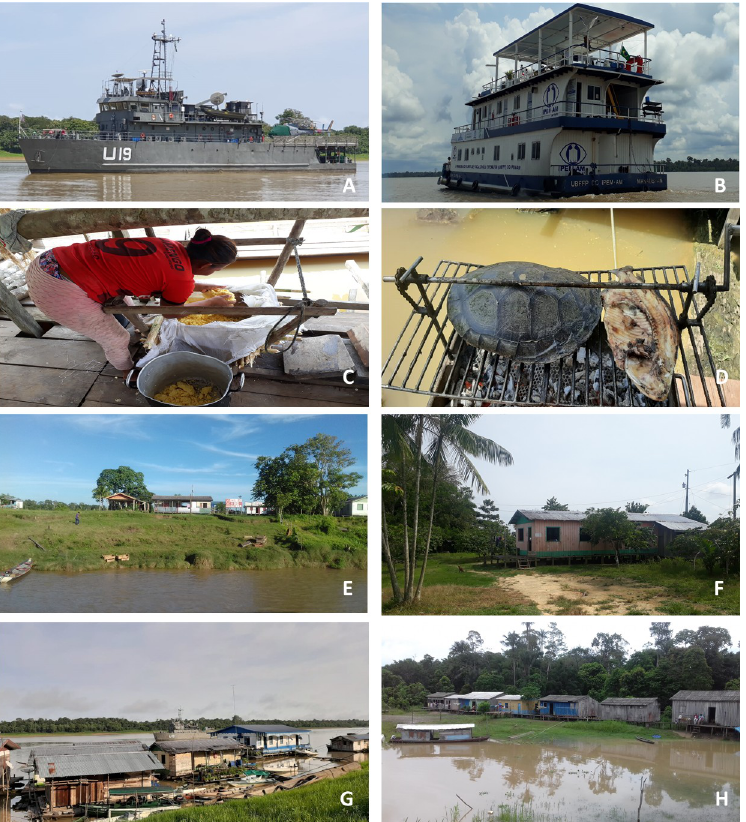
Fig 2. Means of transport used to access communities and characteristics of the communities in the study area. On the first trip, the communities located on the banks of the Jurua´ and Solim õ es rivers were visited from January to March 2019. The researchers accompanied the team from the National Metrology Institute (INMETRO), on the Basic River Inspection and Research Unit (UBFFP), which is a vessel that carries out inspection activities and scientific research activities in the Brazilian Amazon (Fig 2A). On the second trip, in October and November 2019, the communities located on the banks of the Purus river were visited along with the Brazilian Navy team on board the Hospital Assistance Ship “Carlos Chagas (U-19)” (Fig 2B). Fig 2C shows artisinal production of manioc flour, one of the subsistence foods and main economic activities of the riverine populations. Fig 2 D shows the preparation of tracaja´ ( Podocnemis unifilis ), a chelonian considered a delicacy of Amazonian cuisine, hunted and consumed by riverside dwellers, and the tambaqui ( Colossoma macropomum ), a regional fish, both consumed as important sources of protein. Fig E shows a typical wooden house, located on dry land, which is not affected by the flood phase of the rivers. Fig F shows a wooden house built on dry land with several fruit trees in the peridomicile, as well as access trails. Fig G shows floating houses, built on logs of large trees that follow the course of rivers in the flood and ebb phases. The picture also shows several canoes, which are an important means of transport and used for short trips. Fig H shows houses built on stilts ( palafitas ) that are close to the primary forest and interconnected by wooden bridges. Pictures were taken by the first author.